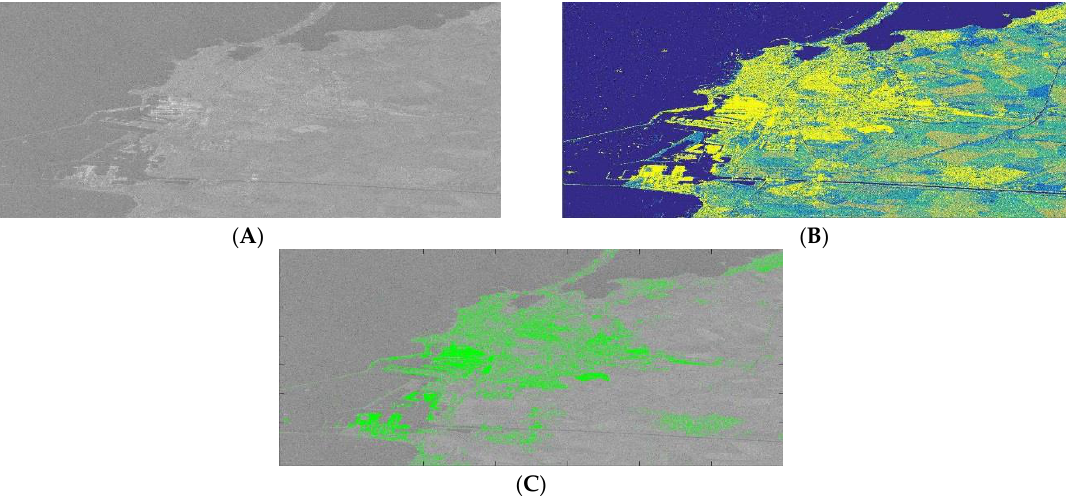
Figure 11. Single-Look Sentinel-1 image amplitude, Constanta ( A ); Scene classification map presenting categories of evolution ( B ); spatial distribution of detected Persistent Scatterers ( C ).